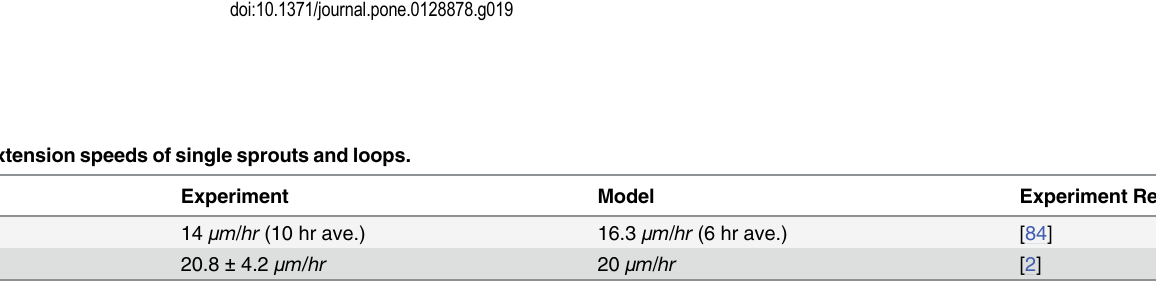
Fig 19. Extension speed of sprouts, averaged in time intervals of 2 hr. After 6hr, a loop is formed and a jump in extension speed occurs.